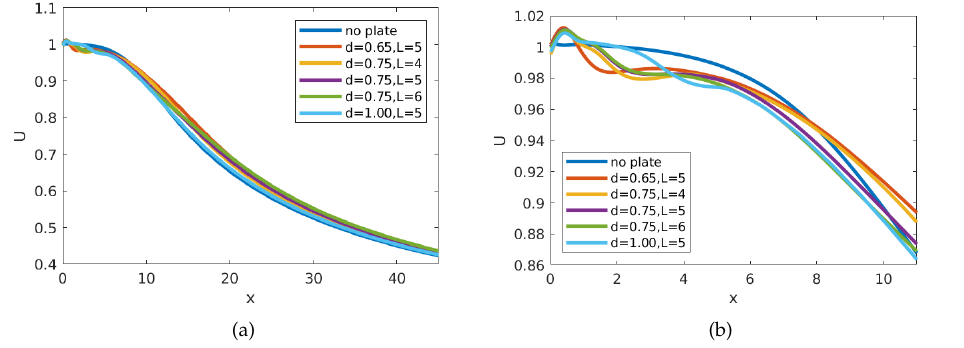
Figure 3. Mean streamwise velocity along the jet centerline from RANS: ( a ) x from 0 to 45; ( b ) details in the core region with x from 0 to 12.